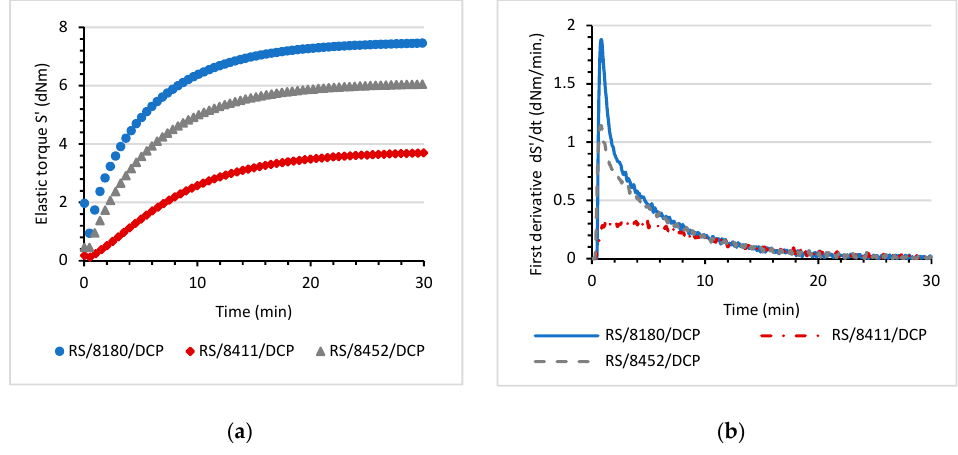
Figure 3. ( a ) The elastic torque S (cid:48) (dNm) as a function of time, ( b ) the first derivative of elastic torque dS (cid:48) /dt (dNm · min − 1 ) as a function of time; each for various RS/TPE/DCP blends. All investigated RS/TPE/DCP blends showed typical curing plots characteristic for elastomers cured by peroxide. Although, the type of thermoplastic elastomer used to prepare the blend strongly influenced the kinetics of curing the final RS/TPE/DCP material. The RS/8180/DCP blend showed the highest increase of elastic torque (S (cid:48) ) during curing. In contrast, the progress of the peroxide curing reaction of RS/8452/DCP blend was restricted, resulting in lower values of S (cid:48) after 30 min of curing. The first derivative dS (cid:48) /dt blends, the local maxima of the first derivative dS (cid:48) /dt were observed at different times, for RS/8452/DCP blend, a slower speed of curing was recorded. Moreover, the maximum value of the first derivative dS (cid:48) /dt was significantly lower, confirming that the achieved ultimate state of cure was lower. With respect to the reaction speed, both 8180 and 8411 significantly affected the cure rate of the RS/TPE/DCP blends. The maximum cure rate was recorded at a shorter time compared to the RS/8452/DCP blend. Although RS/8180/DCP and RS/8411/DCP differed in the maximum value of the first derivative dS (cid:48) /dt, the higher ultimate state of cure was observed for RS/8180/DCP